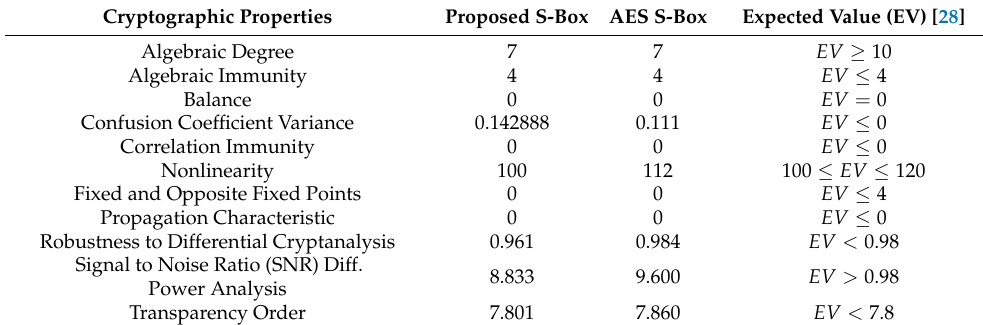
Table 2. Comparison of cryptographic properties between the proposed S-Box and AES S-Box. Cryptographic Properties